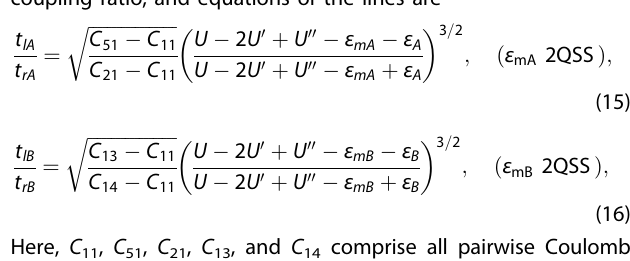
ffiffiffiffiffiffiffiffiffiffiffiffiffiffiffiffiffiffiffi C 51 (cid:3) C 11